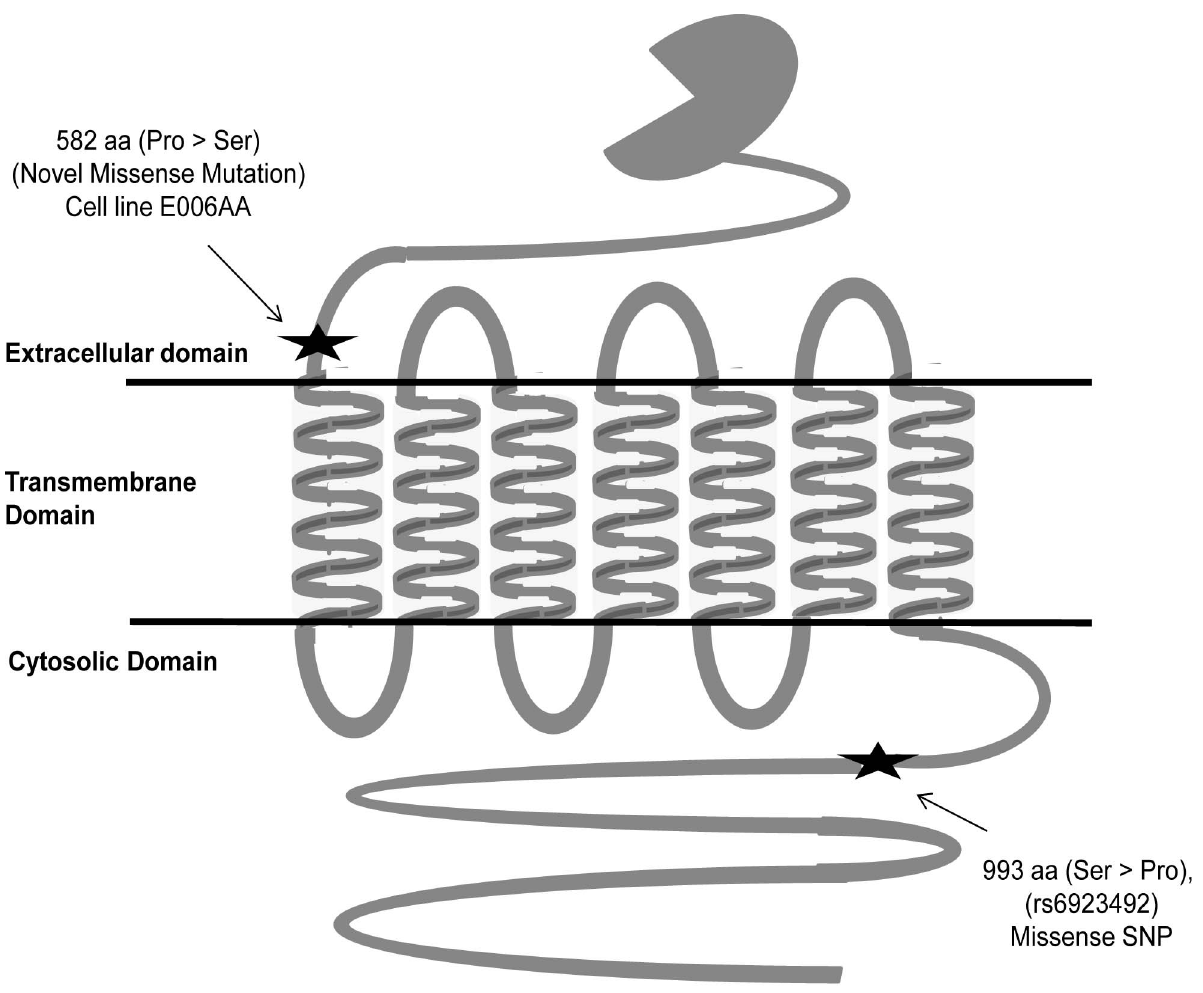
Figure 2. Location of the novel identified mutations and polymorphisms in different domains of GRM1 receptor. doi:10.1371/journal.pone.0103204.g002 Table 1). This mutation resulted in G to T conversion at the start of intron-8 and appeared in heterozygous condition. Five non- coding mutations were also found in 3 9 -UTR region of exon-9 of GRM1 gene in two different PCa cell lines (LAPC4 and MDA- PCa2b) (Table 2). One of these mutations is located at 2149 bp downstream of stop codon in LAPC4 and reported in NCBI data base (dbSNP build 139) as rs41285865. While other four downstream to stop codon in MDA-PCa2b cell line (Table 2).